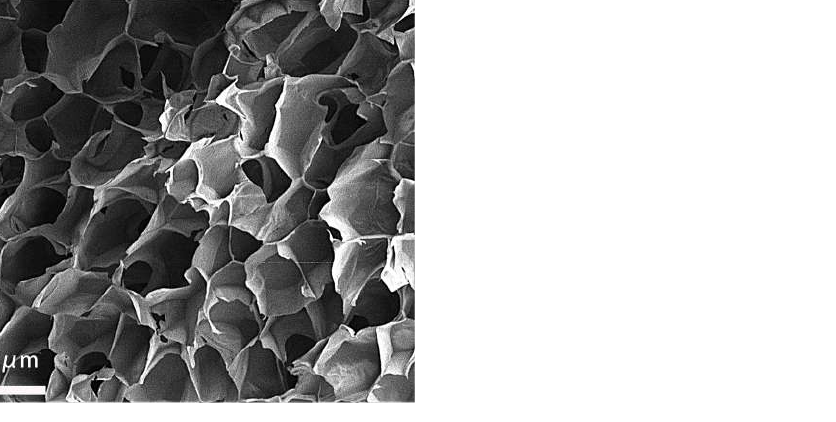
Figure 11. The scanning electron microscopic image of chitosan demethylated sodium cellulose cell scaffolds.